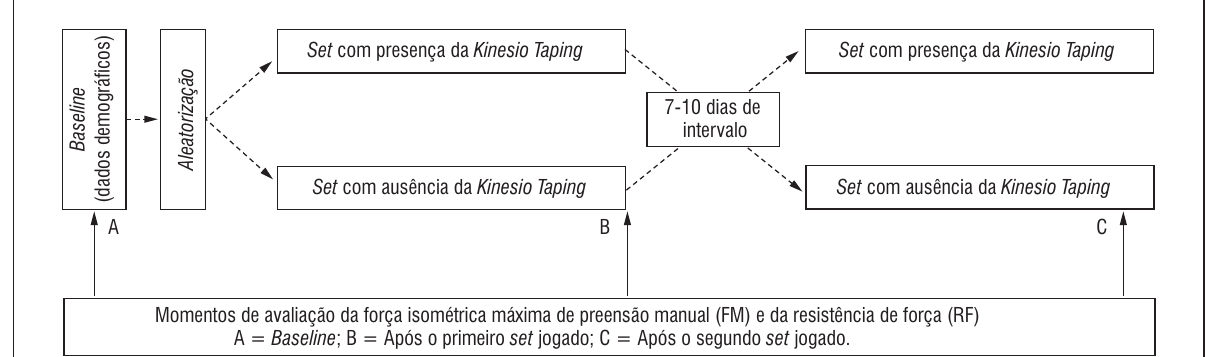
Figura 1 - Delineamento experimental da intervenção Fonte: Dados da